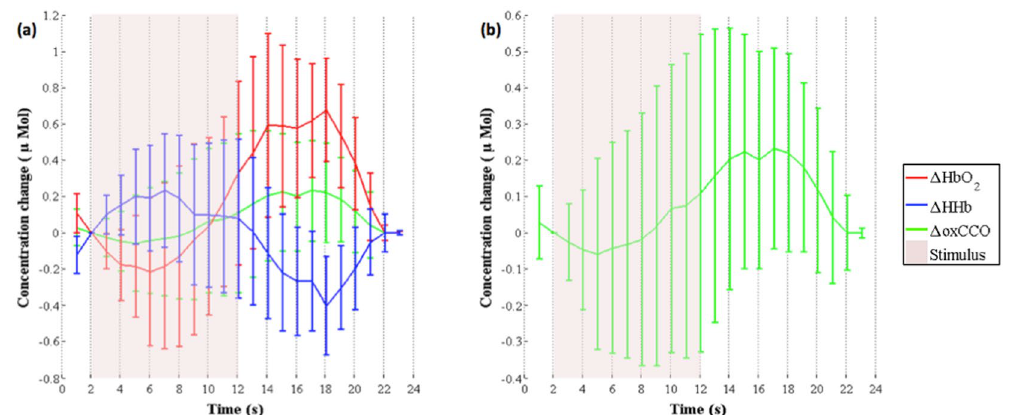
Figure 3. ( a ) Grand median time course of concentration changes in HbO 2 , HHb and oxCCO, across 24 participants. ( b ) Grand median time course of concentration change in oxCCO, with y-axis